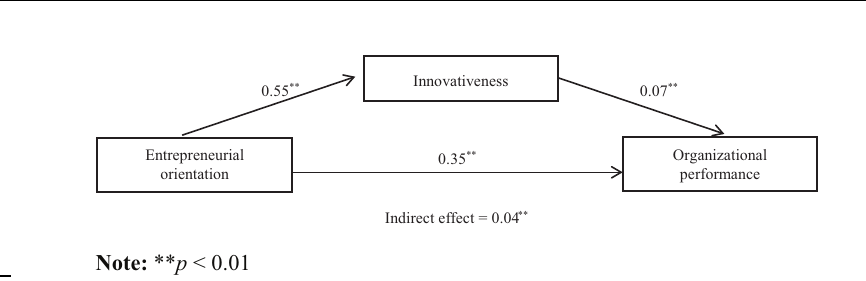
Figure 4. Mediation results of